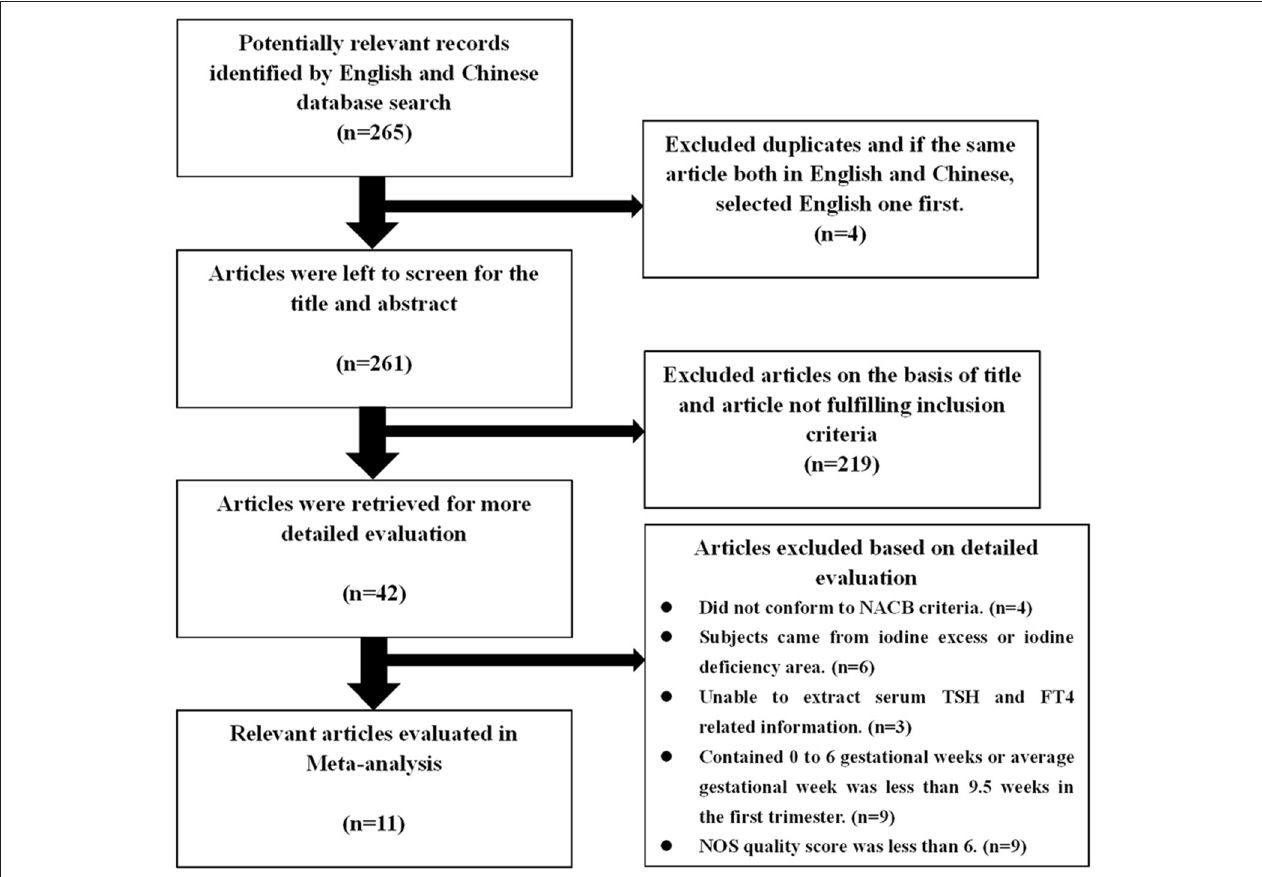
FIGURE 1 | Flow chart of the study selection